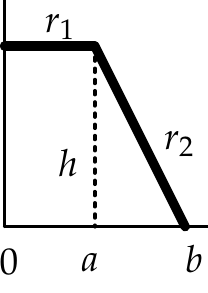
2. Low trapezoidal fuzzy sets generation. This type of fuzzy sets f i , shown in Figure 6, are generated to represent, in each vector D ( f i ) , the components related to the elements with a low value in the characteristic of the corresponding vector.